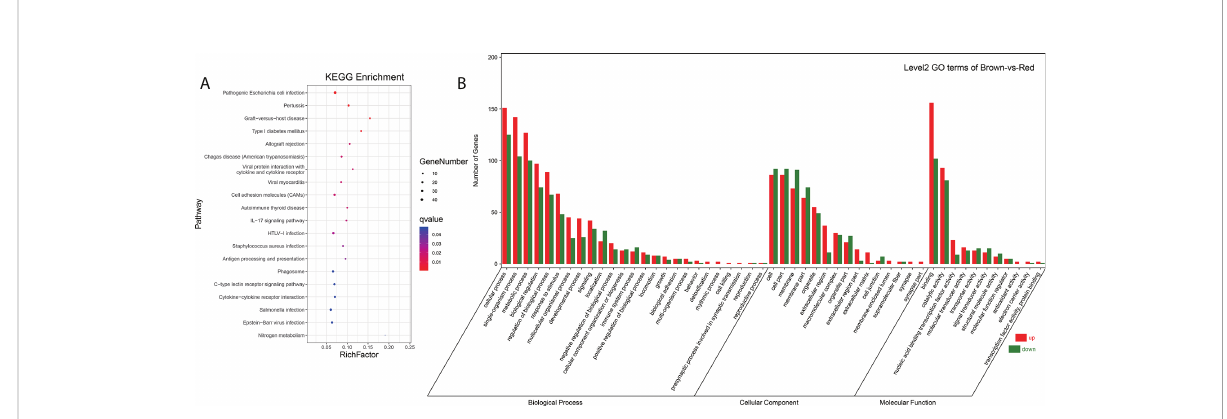
FIGURE 4 Go terms and pathway enrichment analysis of DEMs target genes (A, B) showed pathway enrichment and GO terms analysis, respectively.